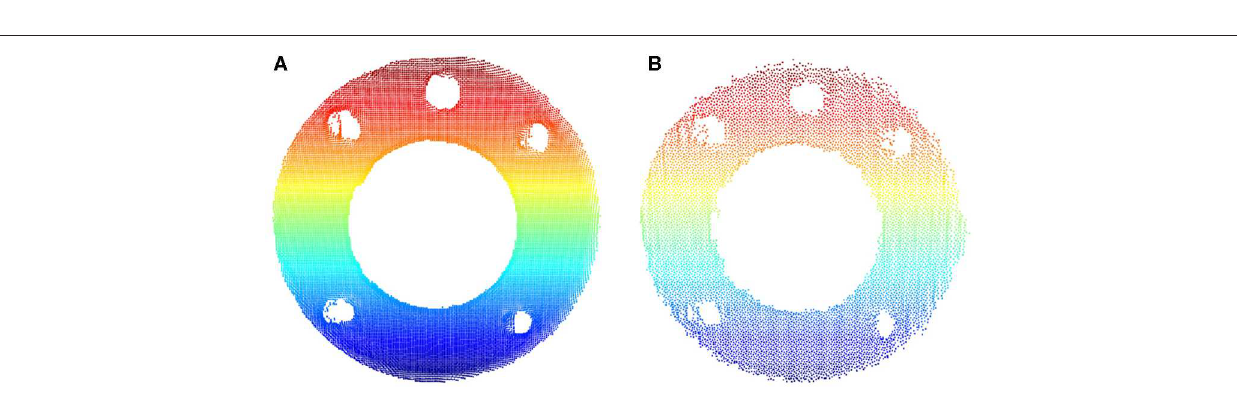
object achieves translational errors of 1 mm and rotational errors of 0.1 degree with much less data and computation.